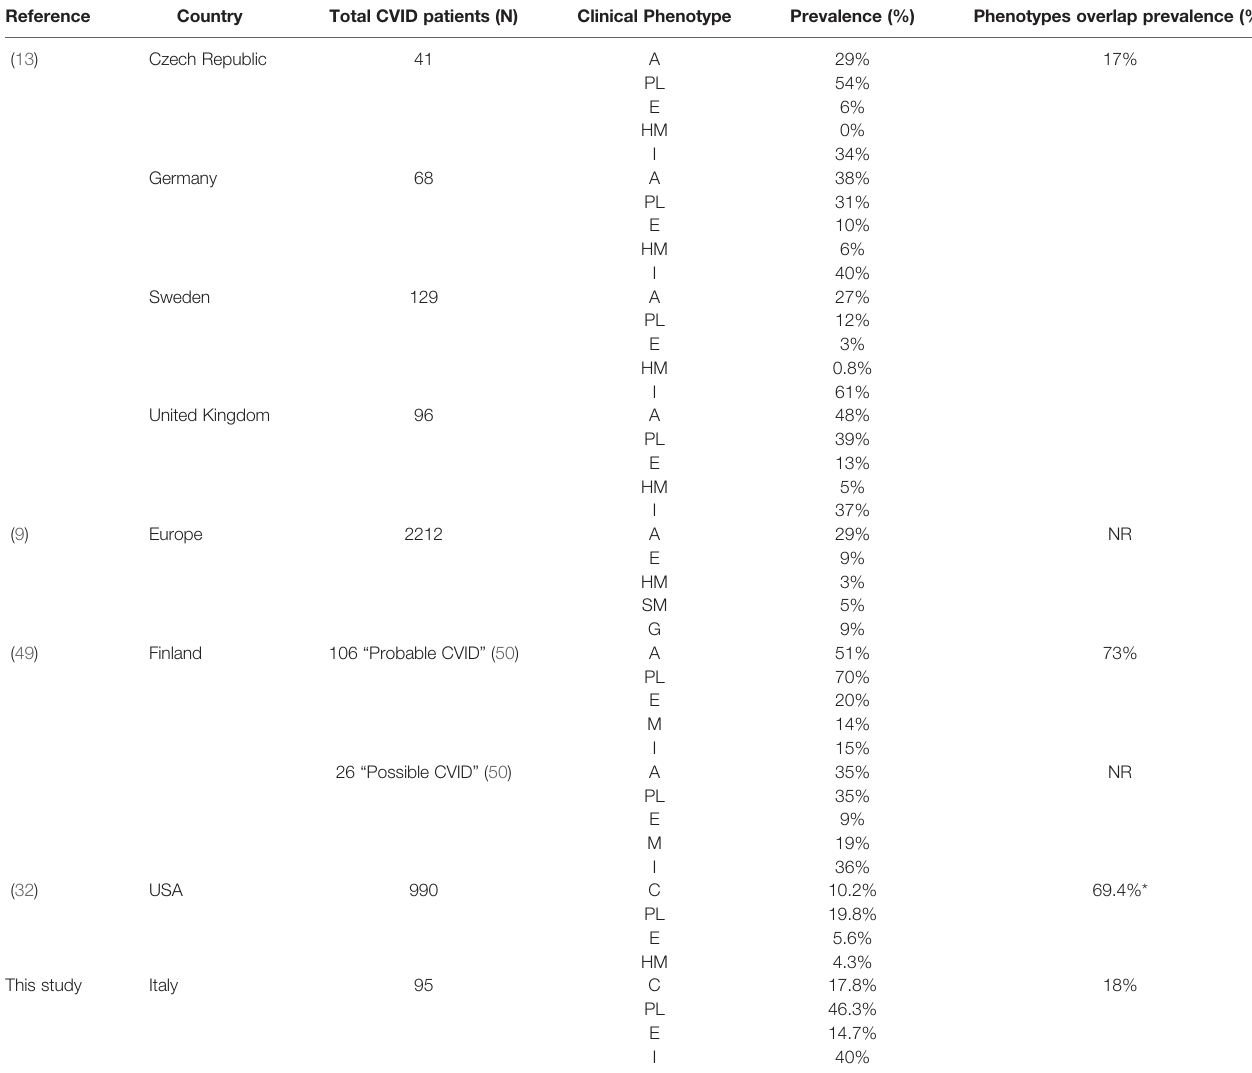
TABLE 4 | Prevalence of CVID clinical phenotypes and their overlap in geographically different cohorts.